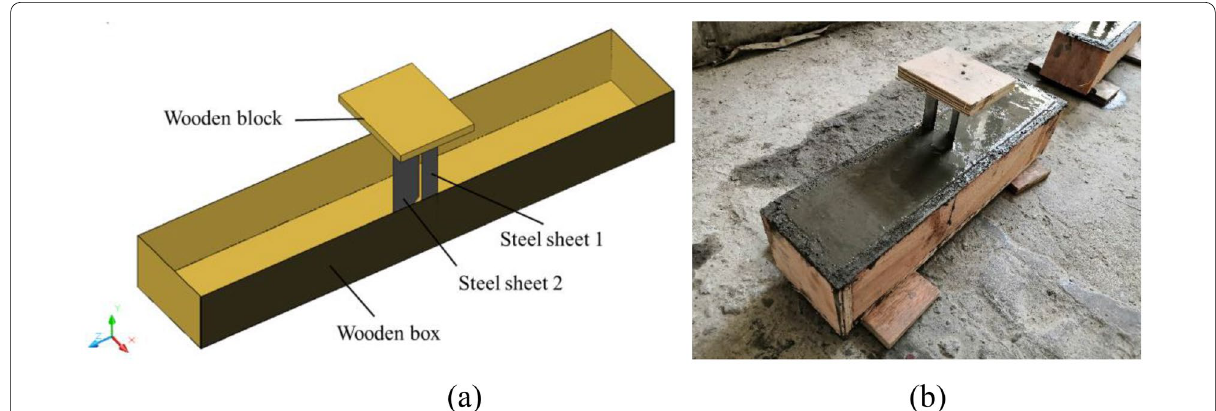
Fig. 4 The specially made wooden formwork for pouring: ( a ) pouring formwork and ( b ) pouring condition